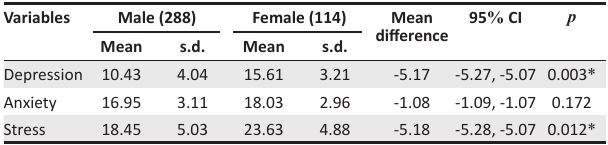
TABLE 3: Difference in psychological symptoms between male and female students.